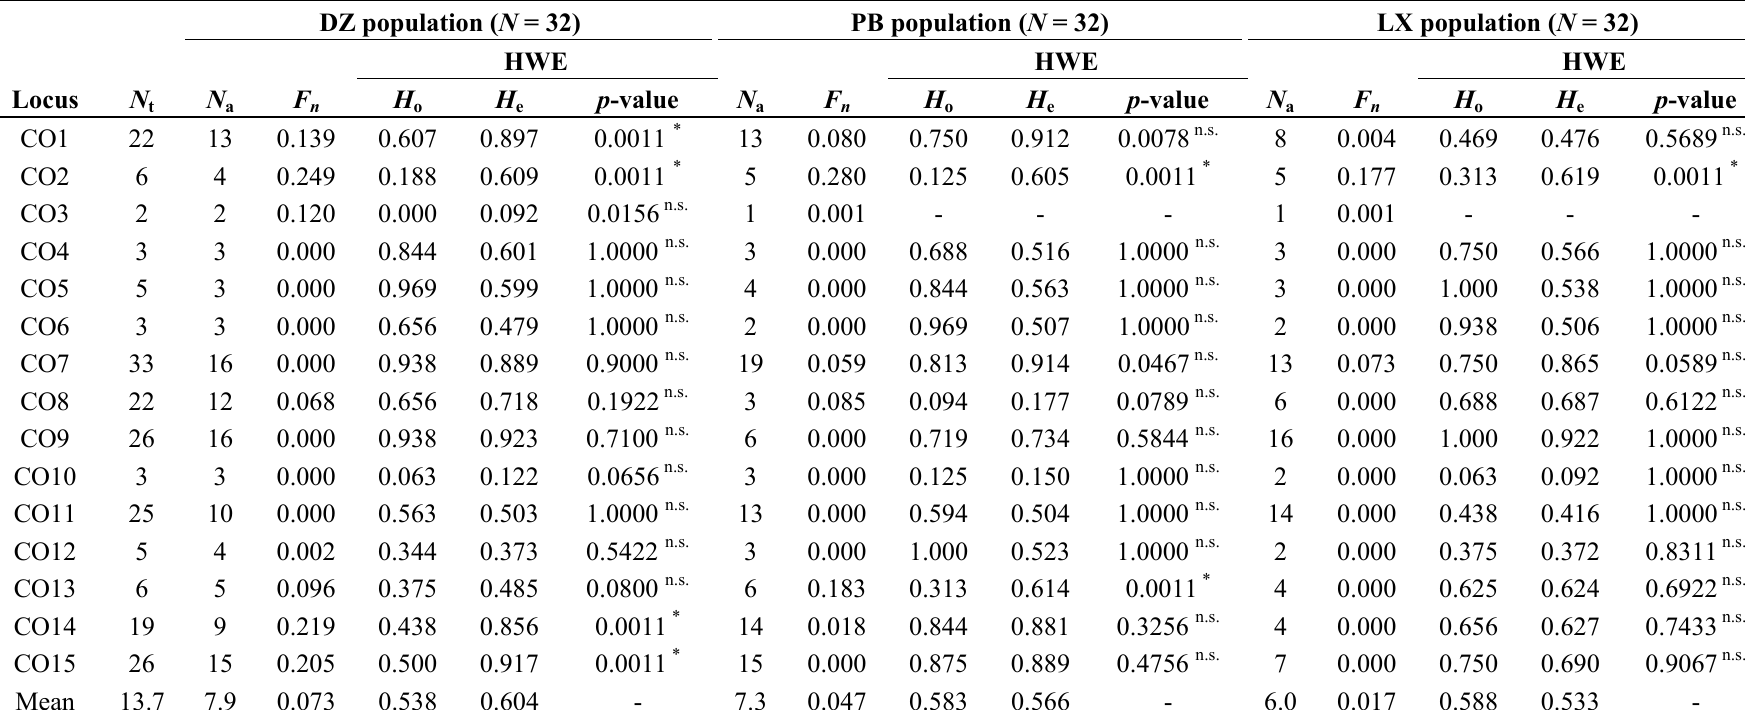
Table 2. Genetic characterization of 15 polymorphic microsatellite loci in three natural populations of Cephalotaxus